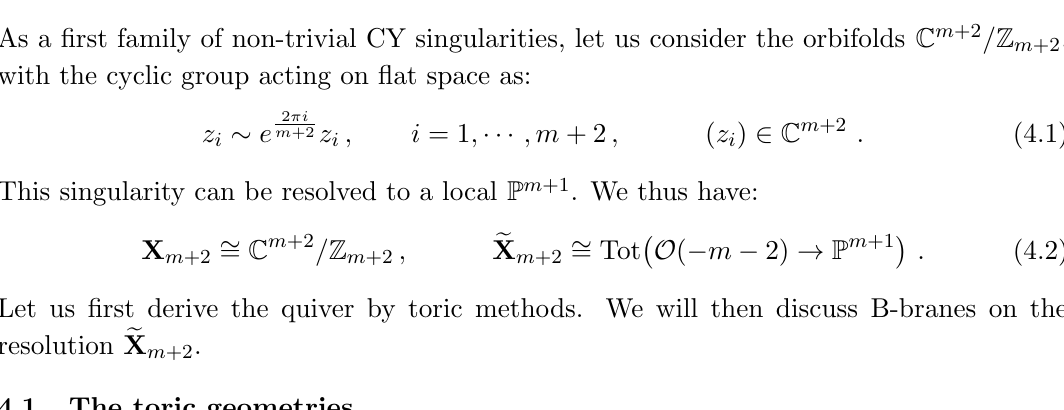
Figure 2 . Toric diagrams for F ( m )